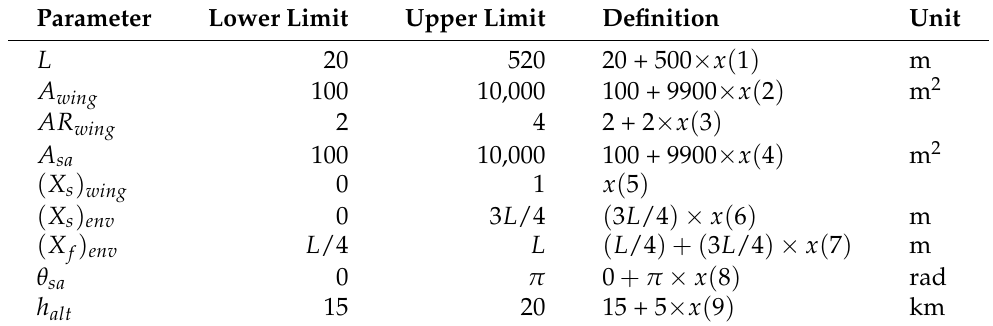
Table 5. Range of design